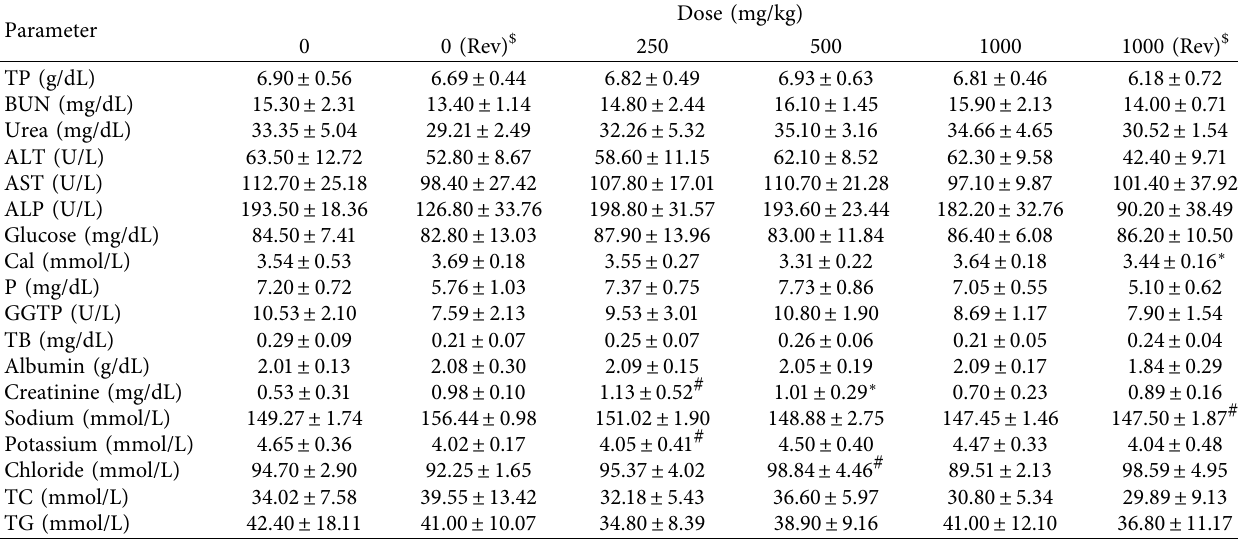
Table 5: Effect of GutGard on biochemistry parameters of male rats during 90D oral toxicity study.